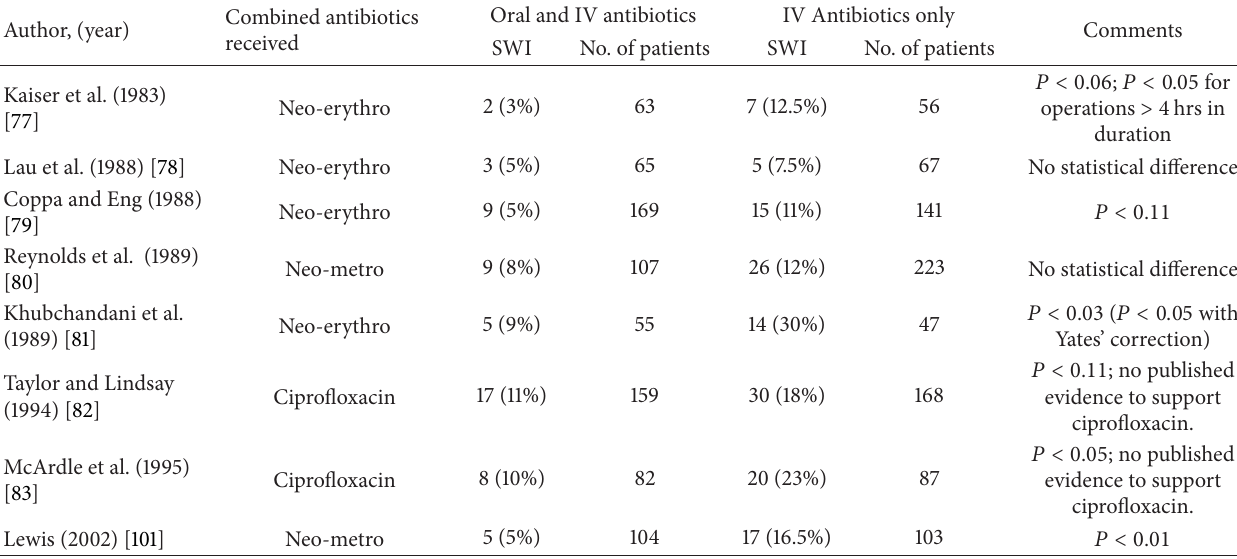
Table 5: This is a summary of studies comparing the oral antibiotic bowel preparation plus systemic antibiotics versus systemic antibiotics alone in elective colon surgery. Only studies with a total study population of 100 or more patients are included. The oral antibiotics used are indicated.